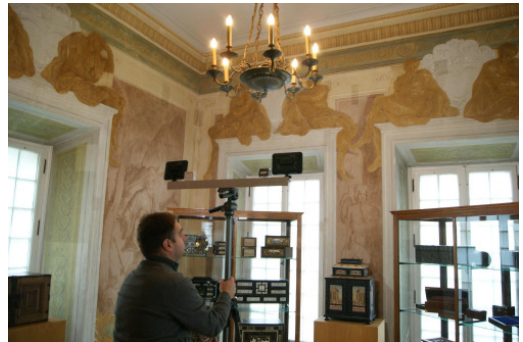
Figure 3. The distribution of control and check points used in images orientation